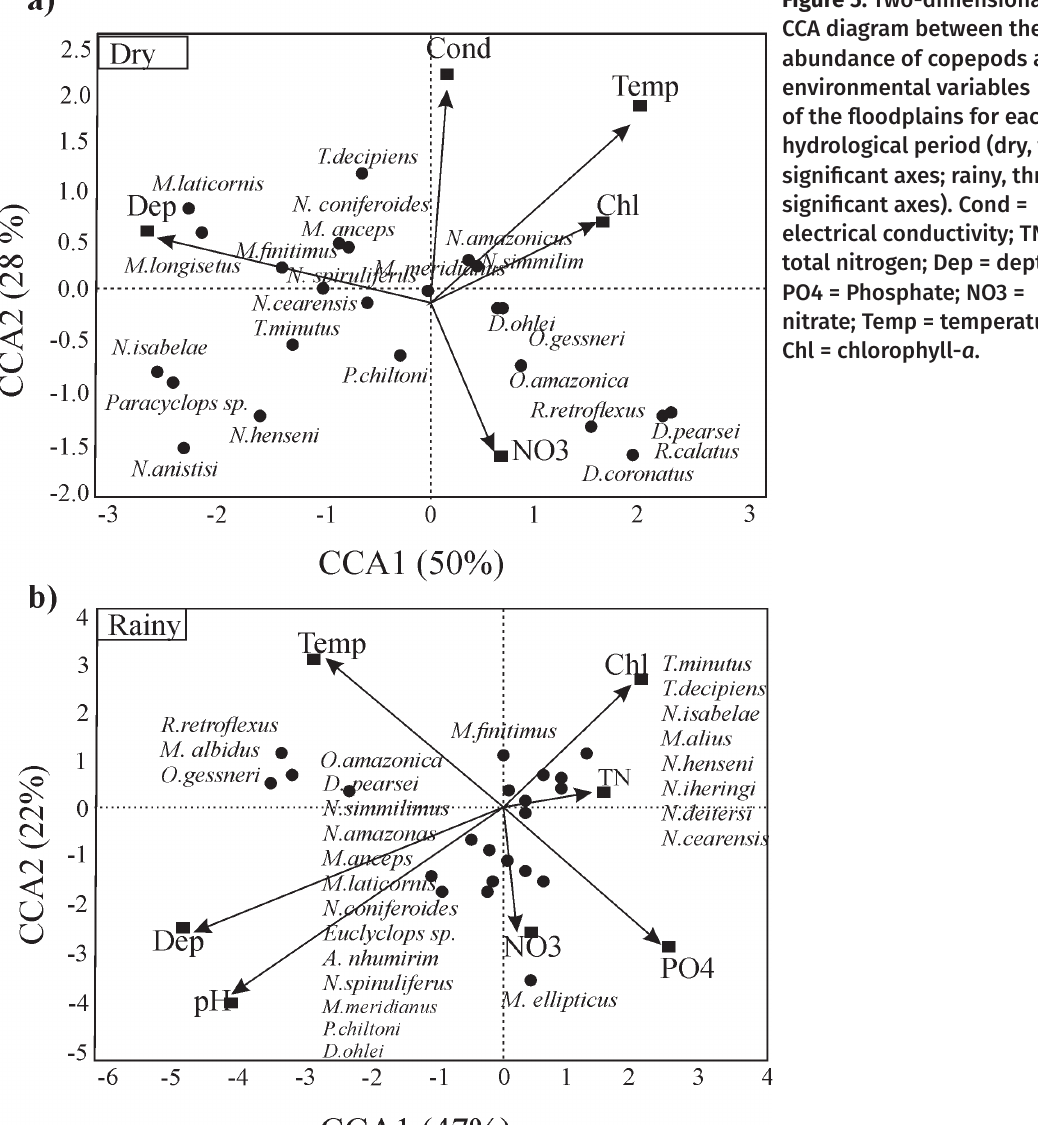
Figure 5. Two-dimensional CCA diagram between the abundance of copepods and of the floodplains for each hydrological period (dry, two significant axes; rainy, three significant axes). Cond = electrical conductivity; TN = total nitrogen; Dep = depth; PO4 = Phosphate; NO3 = nitrate; Temp = temperature; Chl = chlorophyll- a